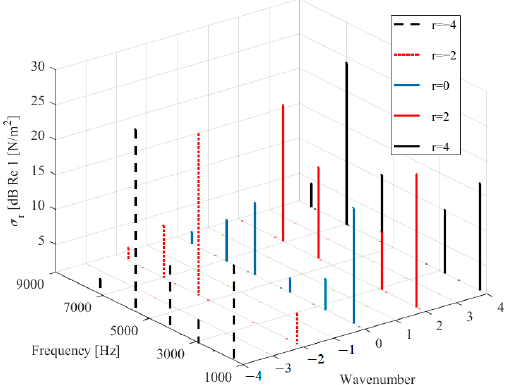
Figure 12. Space-time spectrum of electromagnetic force wave of the motor under normal operating conditions.